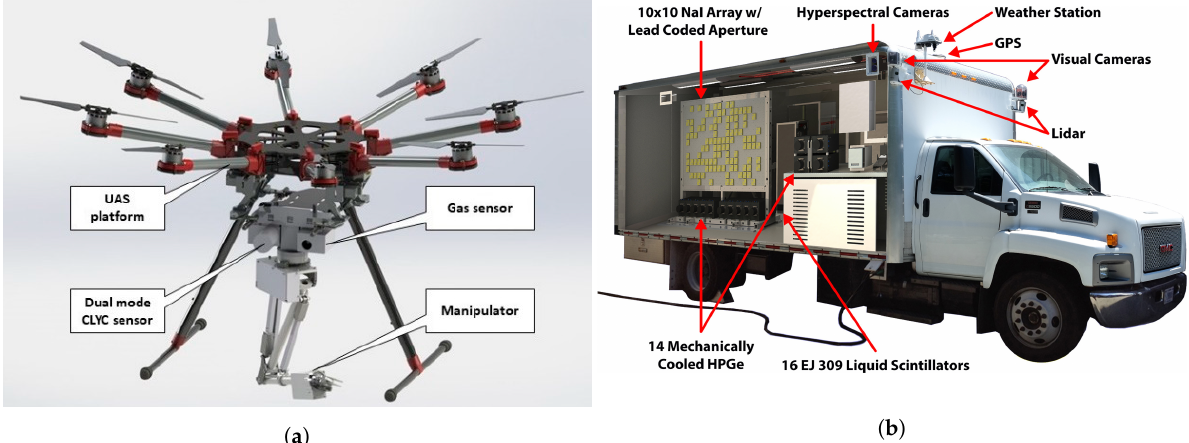
Figure 14. Examples of gamma and neutron detection systems: ( a ) Multi-rotor UAV with a dual-mode CLYC sensor and a manipulator. Reproduced, with permission, from Reference [201]; published by MDPI, 2019, under the terms of the https://creativecommons.or g/licenses/by/4.0/CC BY 4.0 license. ( b ) Radiological multi-sensor analysis platform (RadMap) system carried by a truck showing the lead coded mask (NaI detectors behind), high-purity Ge (HPGe) detectors, and EJ-309 liquid scintillators. Reproduced, with permission, from Reference [204]; copyright Elsevier